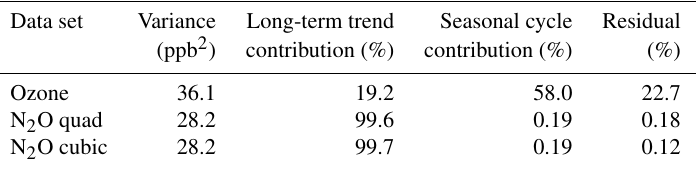
Table 3. Sources of variance in Mace Head, Ireland, data